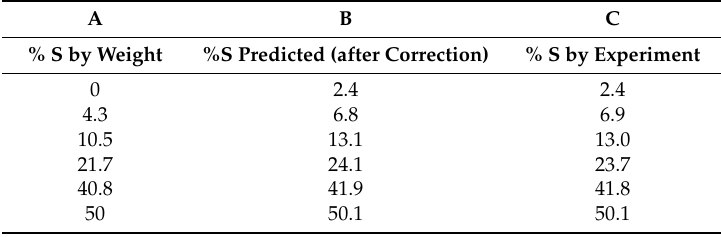
Table 1. Percentage of S enantiomer in artificial mixtures. A: by weight of the two ingredients. B: by weight after correction for the enantiomeric purity and the chemical purity (predicted). C: by 13 C NMR experiment at 260